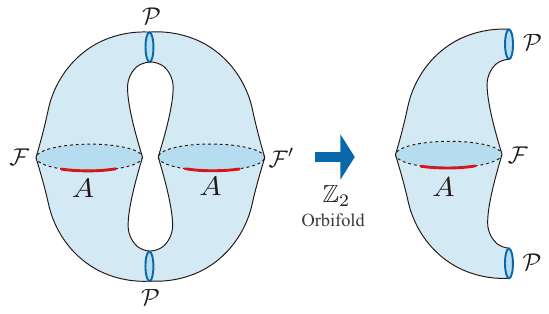
Figure 4 . Double wormholes connecting bra-and-bra and ket-and-ket. Taking Z 2 orbifold of this two wormhole geometry gives the Schwinger-Keldysh geometry with an initial boundary